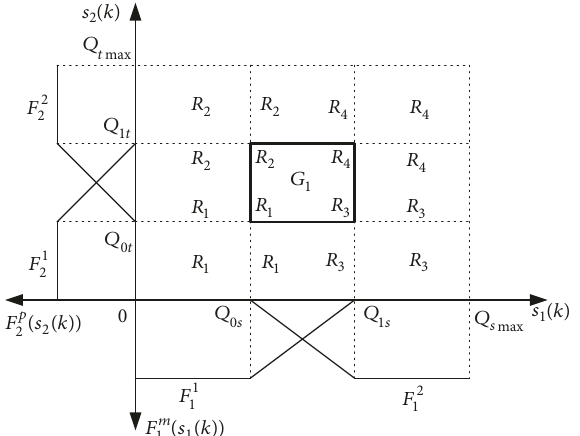
Figure 2: The sketch map of the fuzzy membership functions.